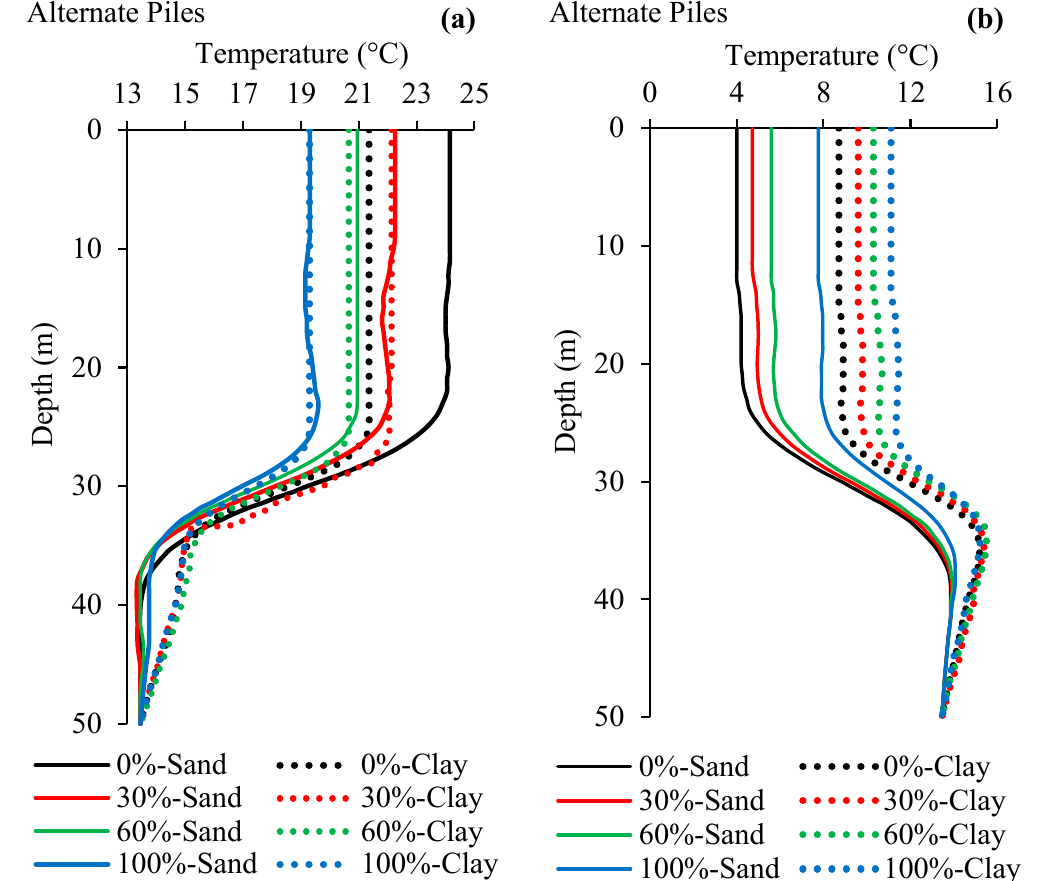
Figure 16. The results of the temperature distribution with depth at the end of 10th cycle: ( a ) maximum and ( b ) minimum .